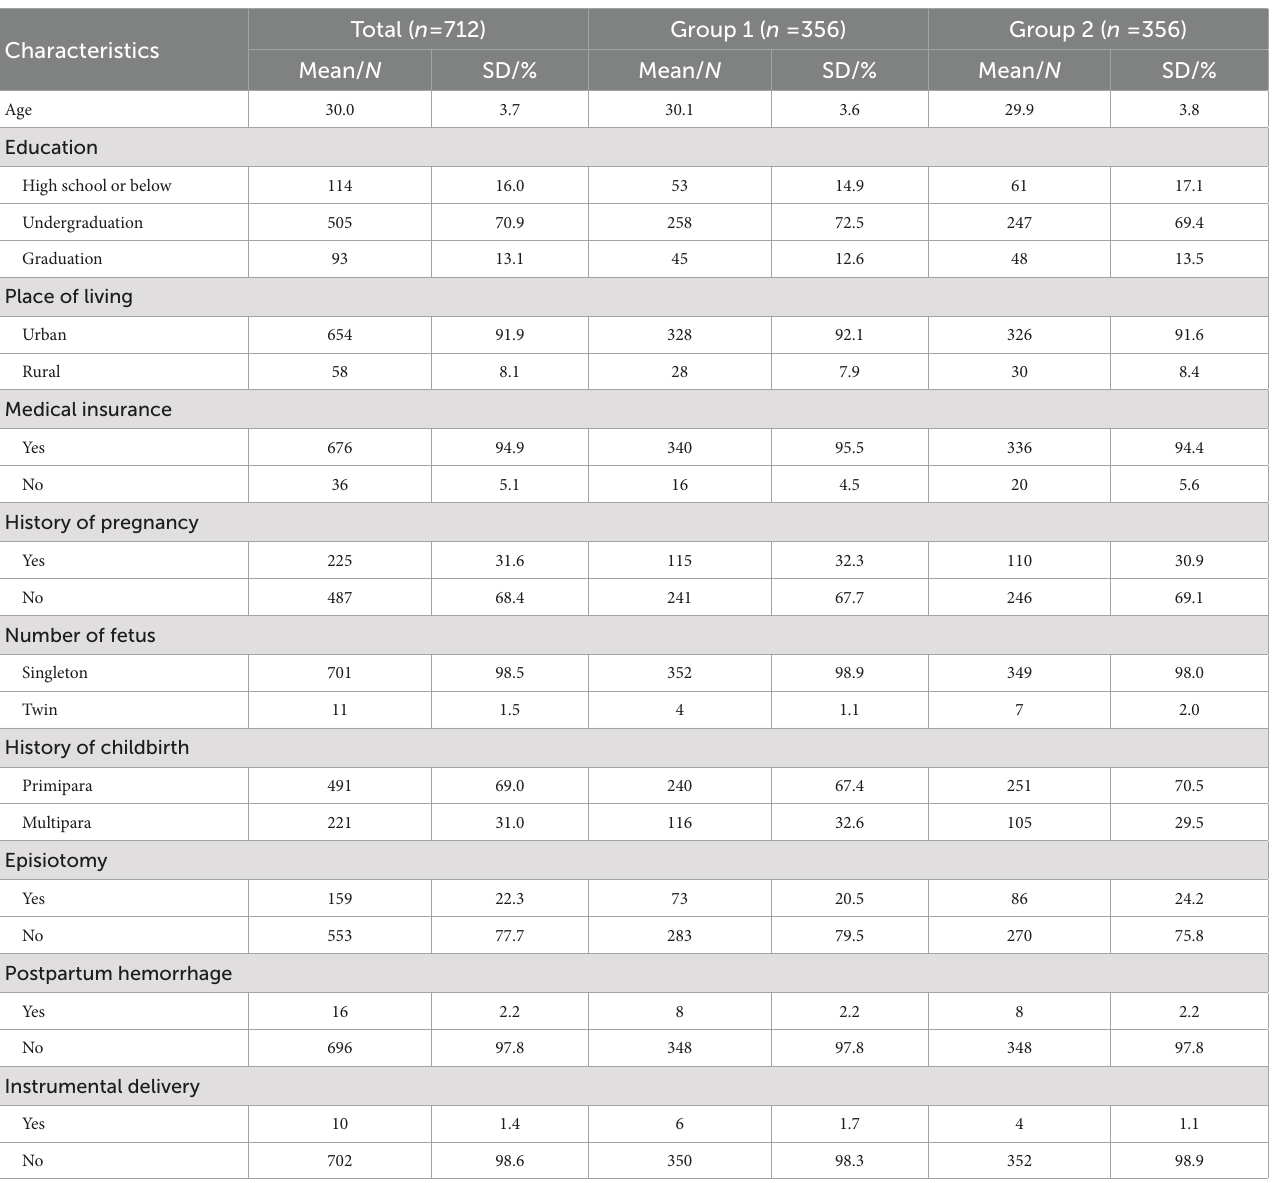
TABLE 1 General characteristics of participants ( n = 712).